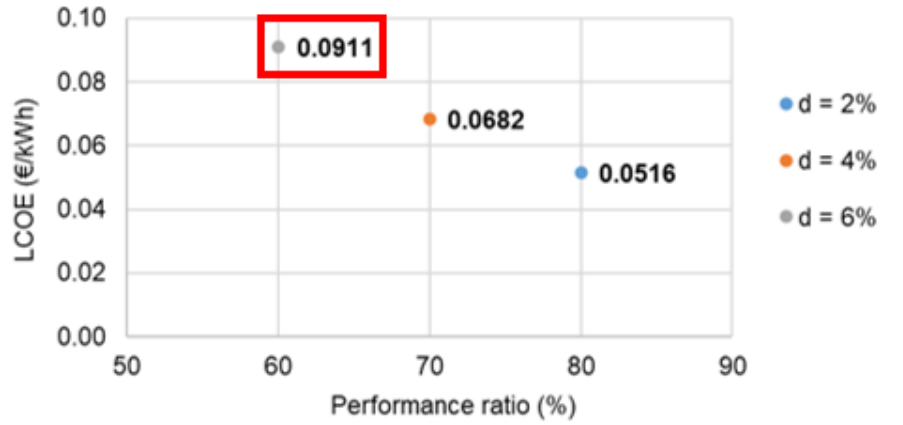
Figure 10. LCOE values under different discount rates and performance ratios.